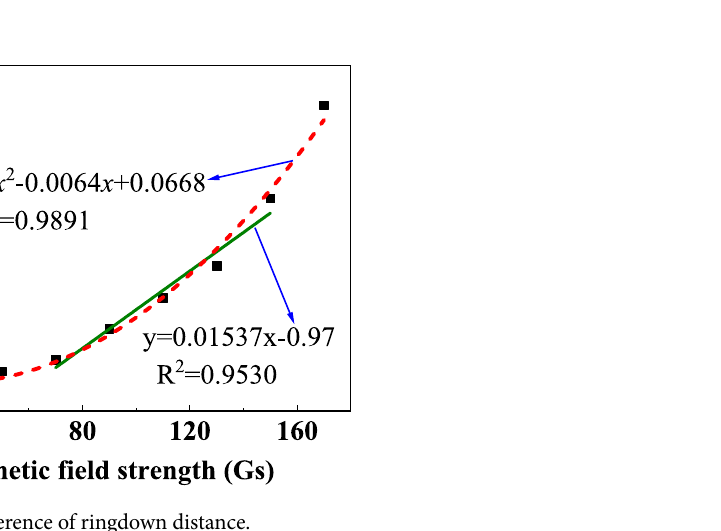
Figure 7. Reciprocal difference of ringdown